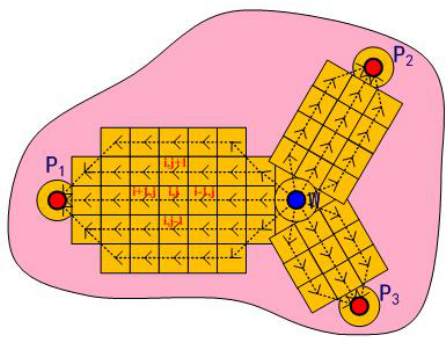
Figure 6—Plane percolation resistance between water injection well and production well in a single